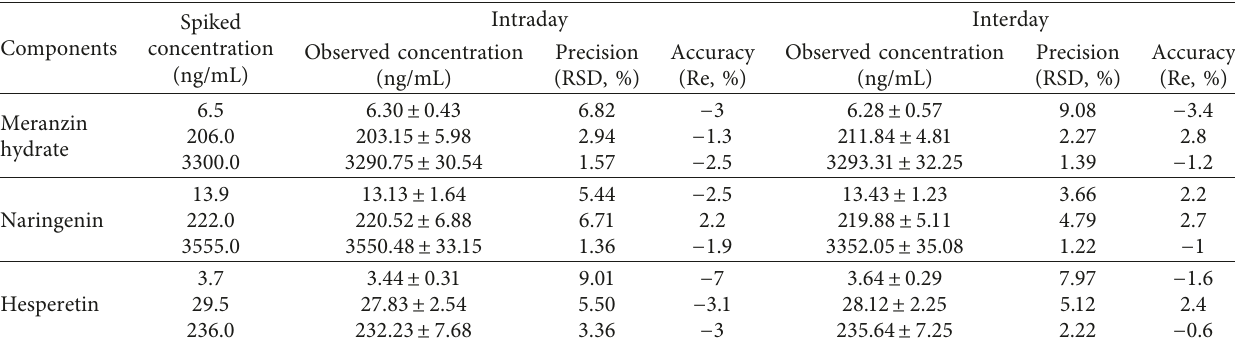
Table 3: Intraday and interday precisions and accuracies of meranzin hydrate, naringenin, and hesperetin in rat plasma ( n � 5). Spiked Components